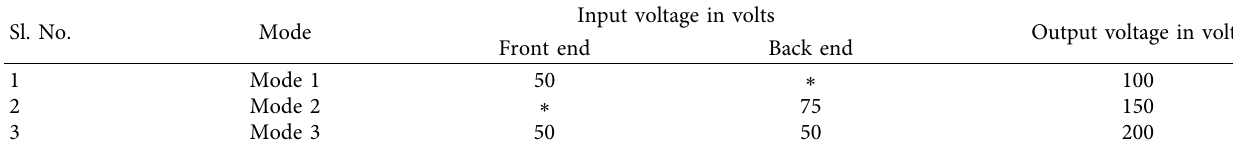
Figure 13: Output waveform during mode 3. Table 3: Input and output voltages for various modes of operation.